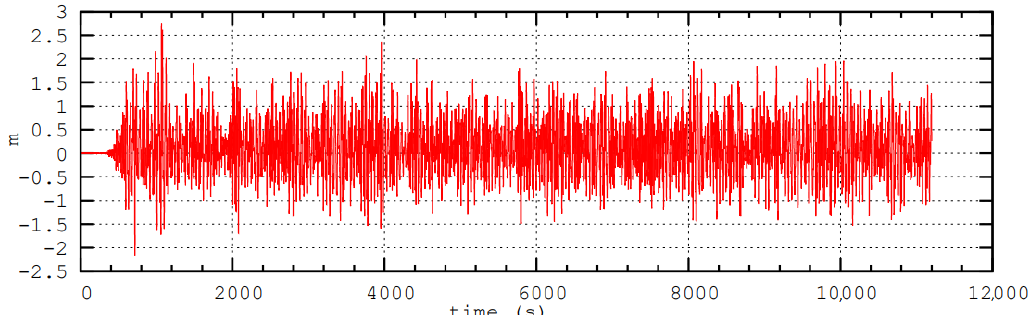
Figure 11. Heave response to IW8 according to experiments.